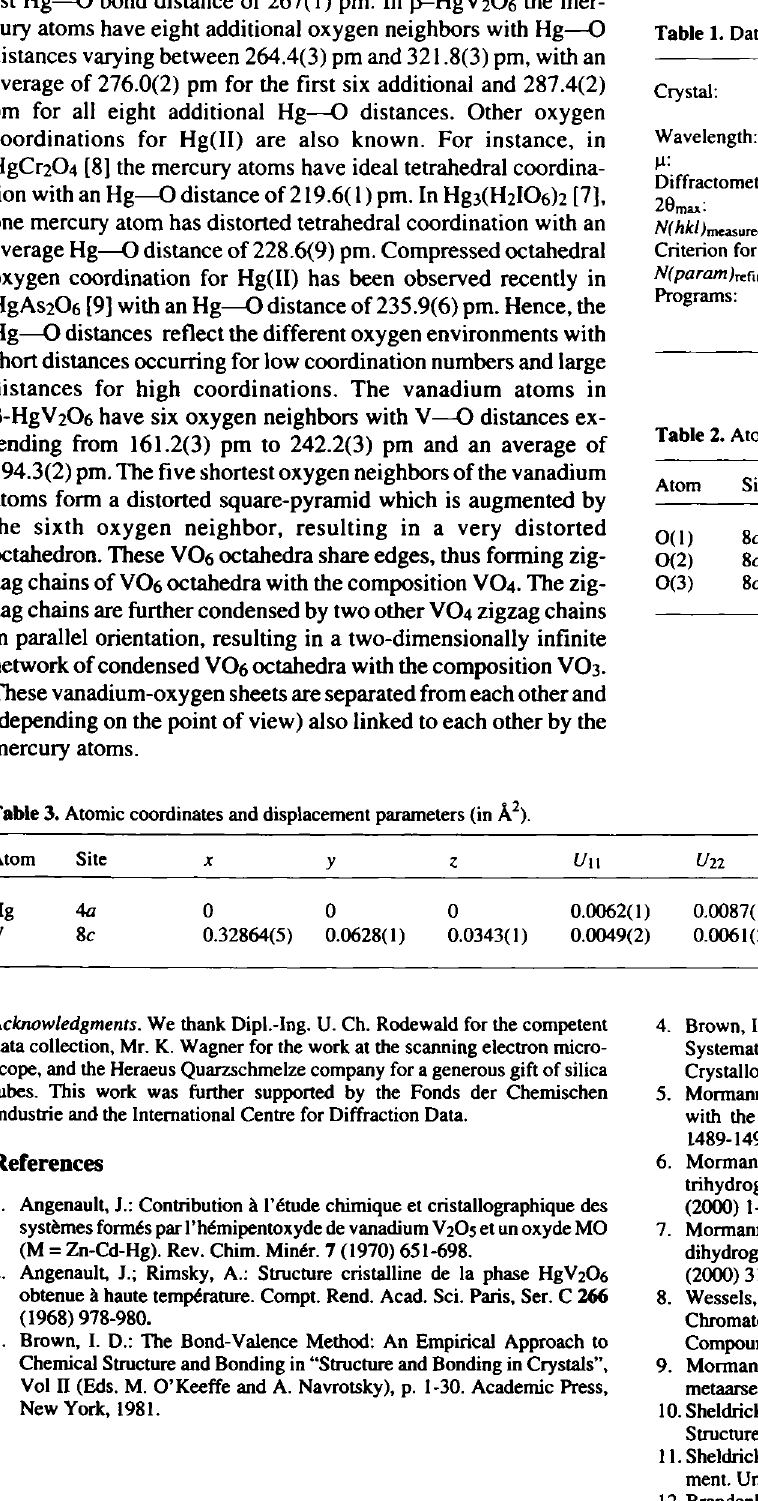
Table 1. Data collection and handling. Crystal: